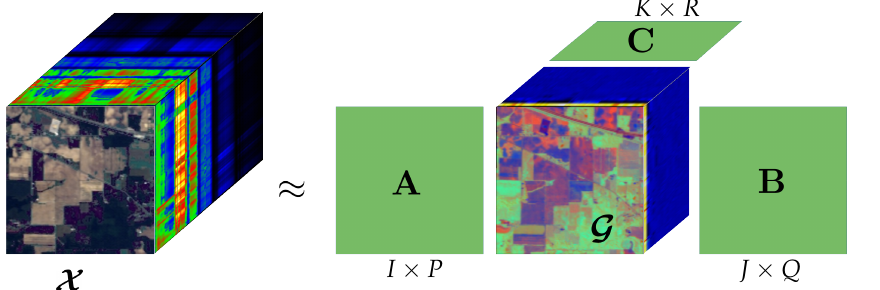
Figure 2. Tucker Decomposition of Indian Pines HSI, a third-order